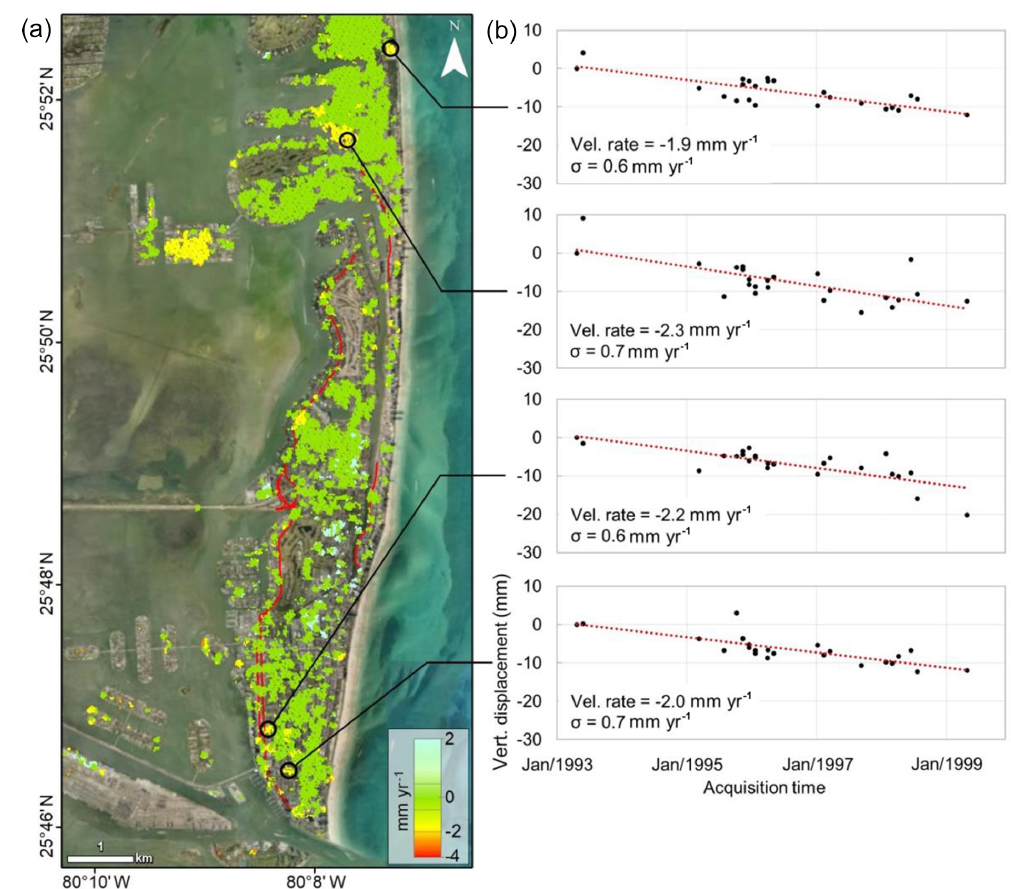
Figure 3. Vertical velocity map over Miami Beach from 1993–1999 and displacement time series (from Fiaschi and Wdowinski, 2019). (a) vertical velocity map obtained with the SBAS technique. The black circles mark the location of the extracted displacement time series. Red lines mark the location of roads affected by flooding during 1998–2012 (data from Wdowinski et al., 2016). Base image source: Esri, DigitalGlobe, GeoEye, Earth Geographics, CNES/Airbus DS, USDA, USGS, AeroGRID, IGN, and the GIS User Community. (b) Vertical displacement time series of the four selected